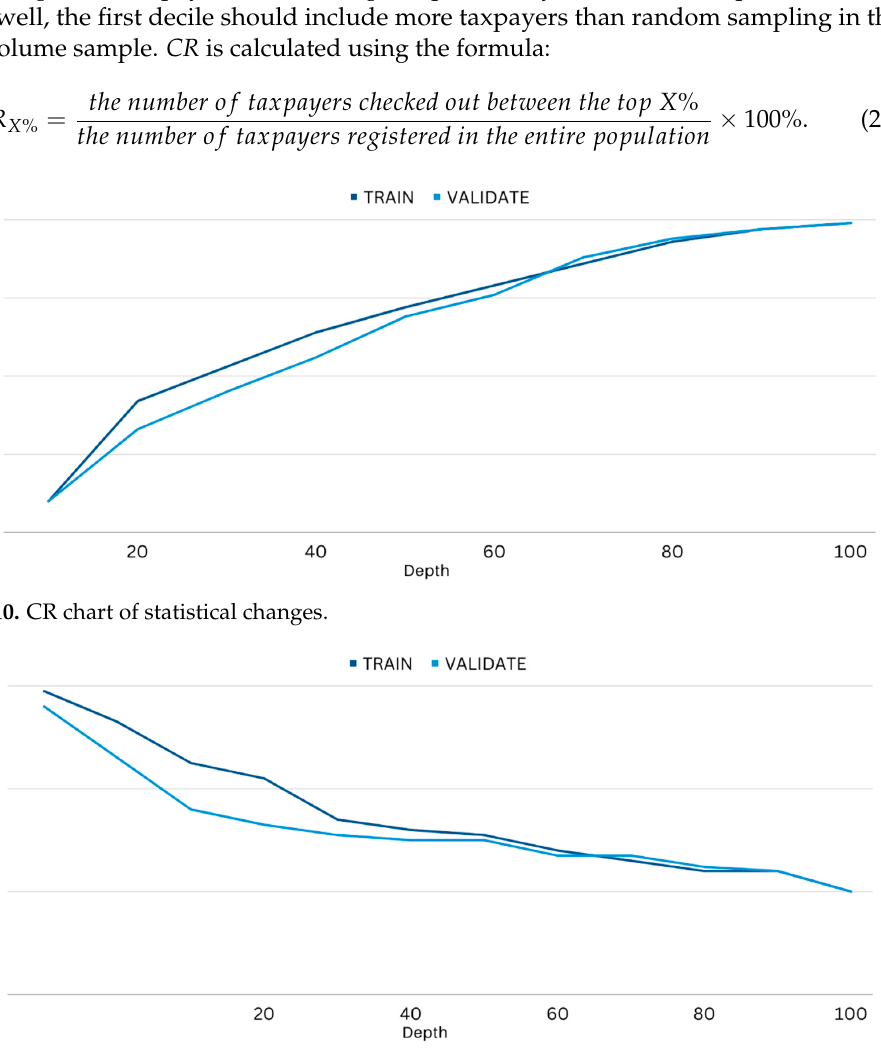
Figure 11. LIFT chart of statistical